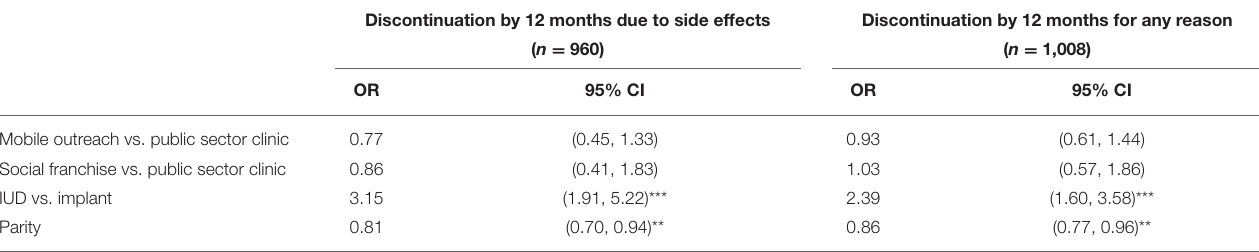
TABLE 3 | Adjusted OR from final model for factors associated with discontinuation by 12 months due to side effects and all-cause discontinuation.